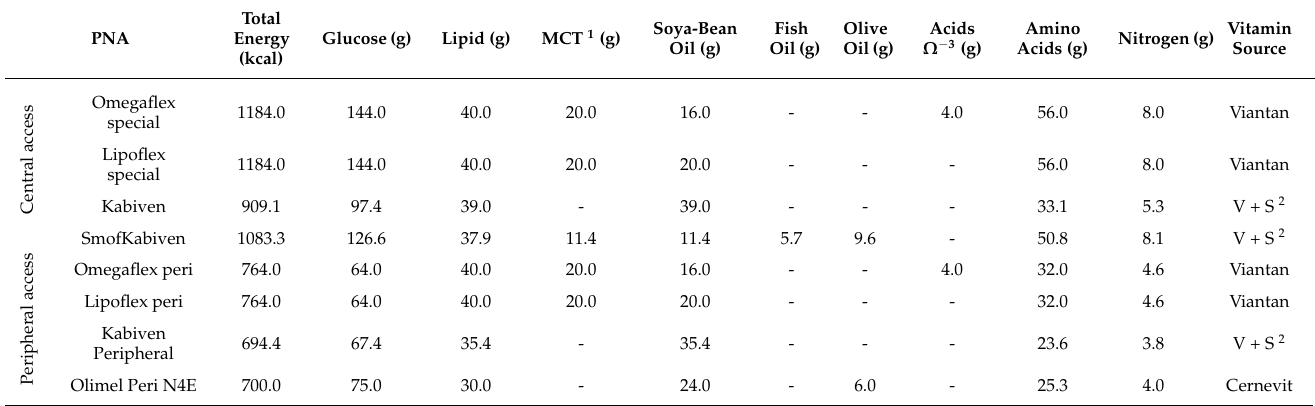
Table 1. Composition comparison of studied parenteral nutrition admixtures (volume 1000 mL).